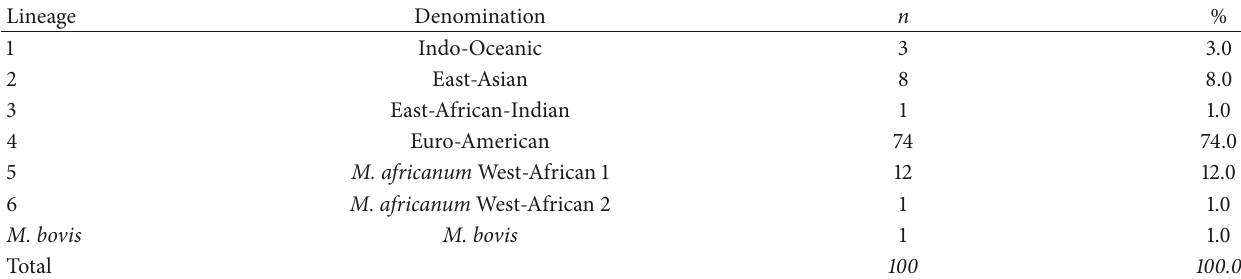
Table 4: Strains per lineage.